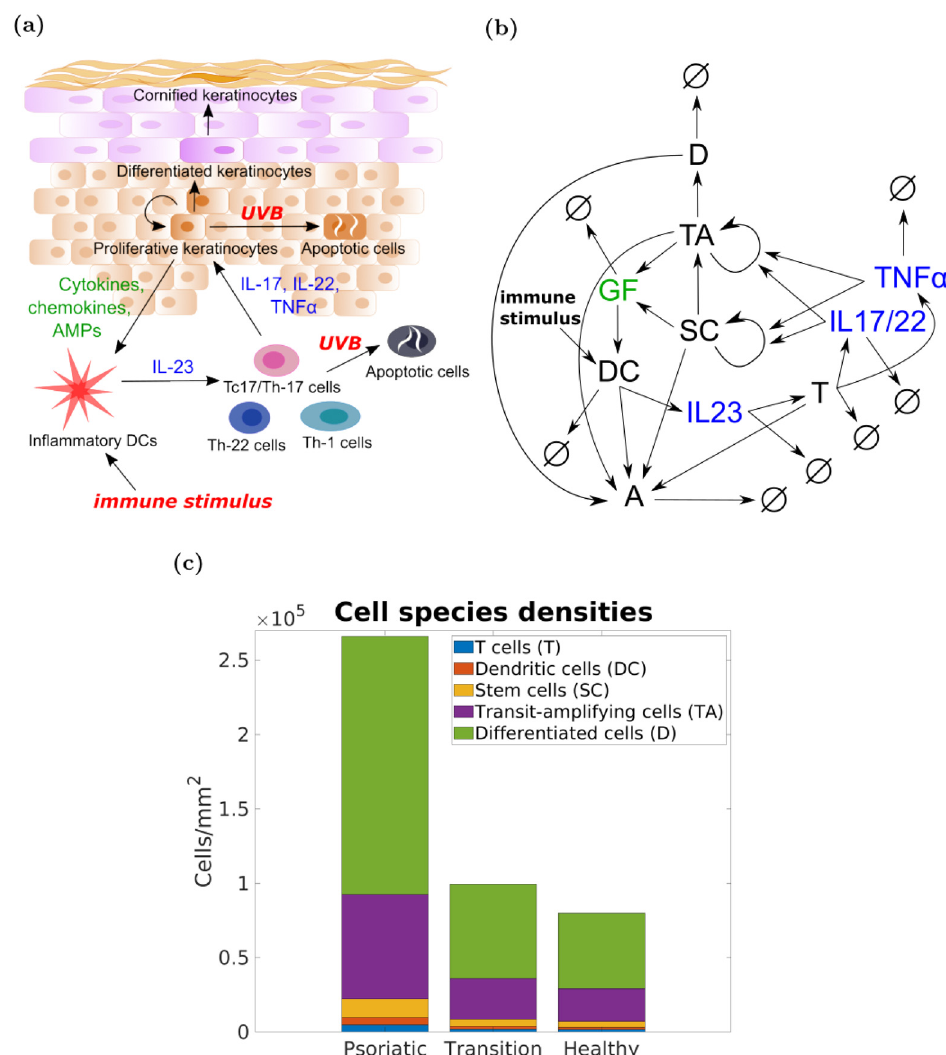
Fig 1. Our ODE model of epidermis describes an explicit interaction between the main types of keratinocytes and immune cells mediating psoriasis. Panels: (a)—mechanism of interaction between the main cell types and cytokines in epidermis; (b)—interactions between the species of our model, where SC —stem cells, TA —transit-amplifying cells, D —differentiating cells, DC —dendritic cells, T —T cells, A —apoptotic cells, IL 17/22 —interleukin-17/22, IL 23 — interleukin-23, TNF α —tumour necrosis factor alpha, GF —keratinocyte-derived growth factors, and ⌀ —degradation species; (c)—cell density (cells/ mm 2 ) for every cell type (excluding apoptotic cells) in the healthy (non-lesional skin), psoriatic (lesional/plaque skin) and transition steady